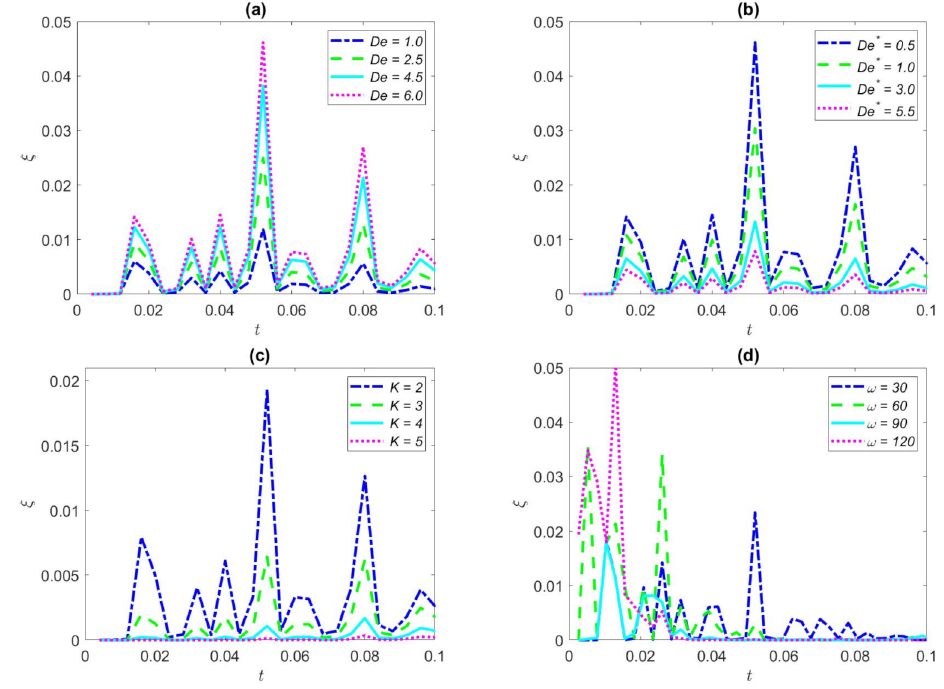
Figure 8. Distribution of the EKEC efficiency of the triangular waveform for some values of De , De * , K , ω . ( a ) De * = 0.5, ϕ = 2%, ω = 20, Ha = 2, K = 1; ( b ) De = 6 , ϕ = 2%, ω = 20, Ha = 2, K = 1; ( c ) De = 1, De * = 0.5, ϕ = 2%, ω = 20, Ha = 1; ( d ) De = 1, De * = 0.5, ϕ = 2%, Ha = 1, K =